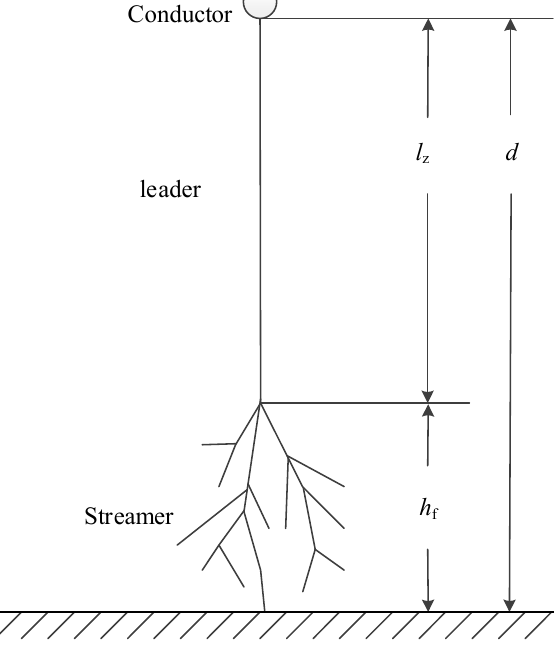
Figure 1. The development process of air gap discharge.